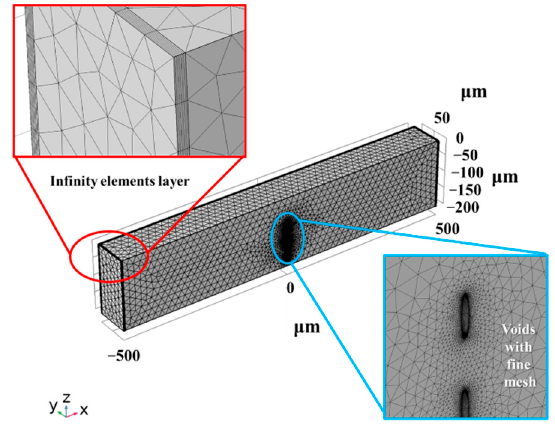
Figure 3. The diagram of the component structure with mesh.